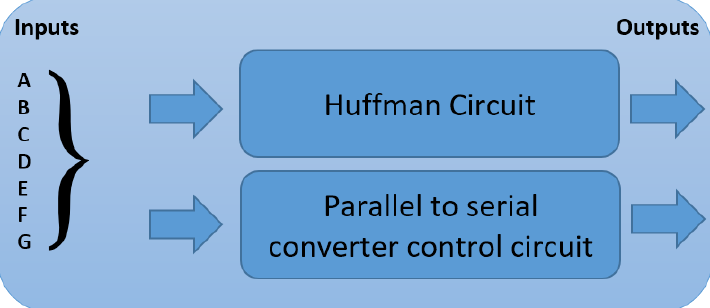
Figure 9. Diagram explained in graph, how the proposed Huffman encoder works and outputs extra bits to provide information to the parallel to serial converter about the width of every processed output. Table 5. Table of data output in correspondence of Huffman output.